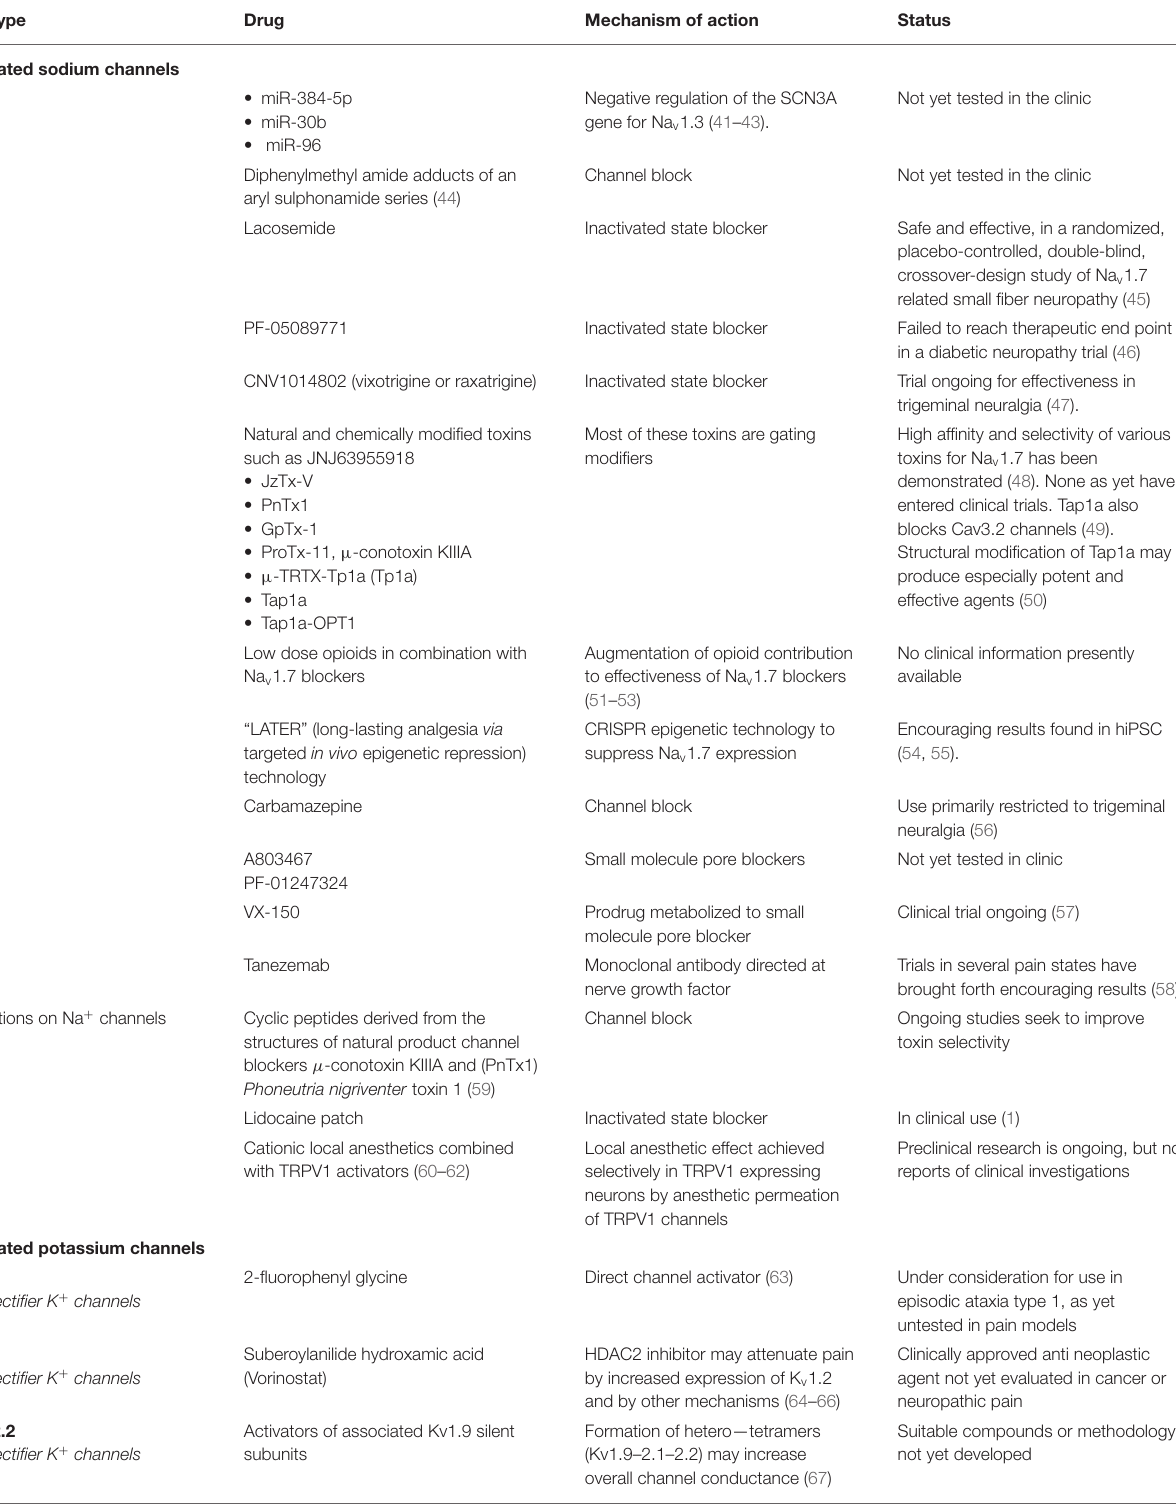
TABLE 1 | Potential and actual therapeutic